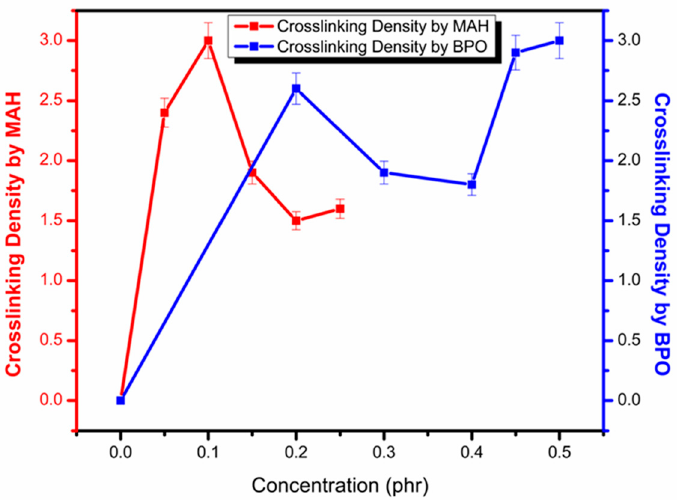
Figure 3. Effect of MAH and BPO concentration on the crosslinking density during the reaction.